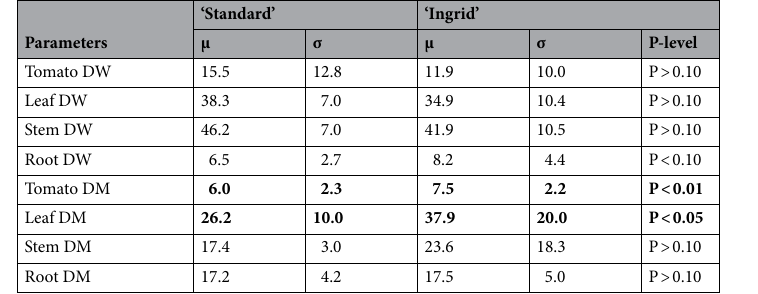
Table 5. Kolmogorov–Smirnov two-sample test for comparison between cultivar ‘Standard and ‘Ingrid’ compared to mean μ and standard deviation σ considering plant parameters. P-levels are reported. Significant differences and significant P-levels marked in bold. Parameters’ legend: dry-weight: DW; dry-matters: